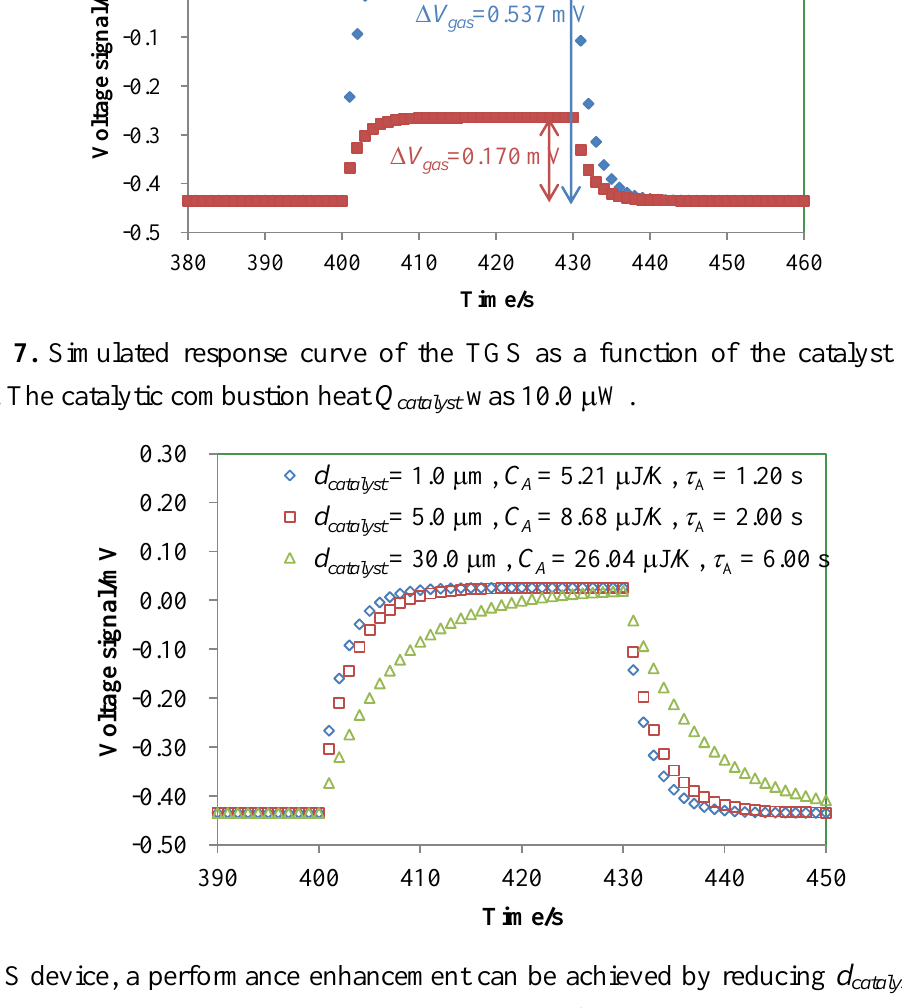
Figure 6. The simulated response curves for  V 11.7  W which correspond to 200 and 1,000 ppm H parameters are unchanged and listed in Tables 1 and 2. The simulation results are from 380 to 460 s. Q is nonzero from 400 s to 430 s. catalyst